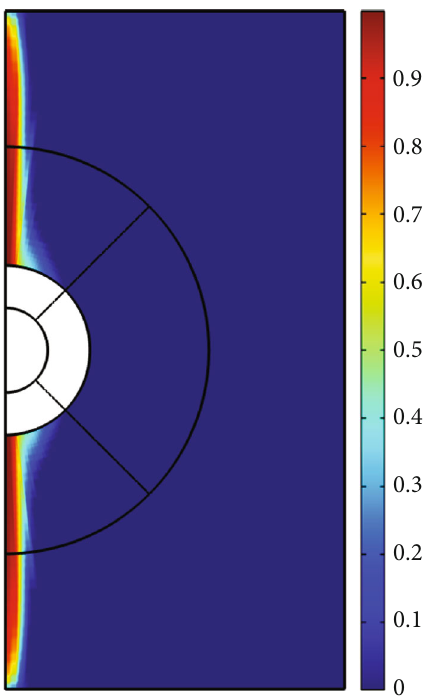
Figure 4: Damage evolution results of group